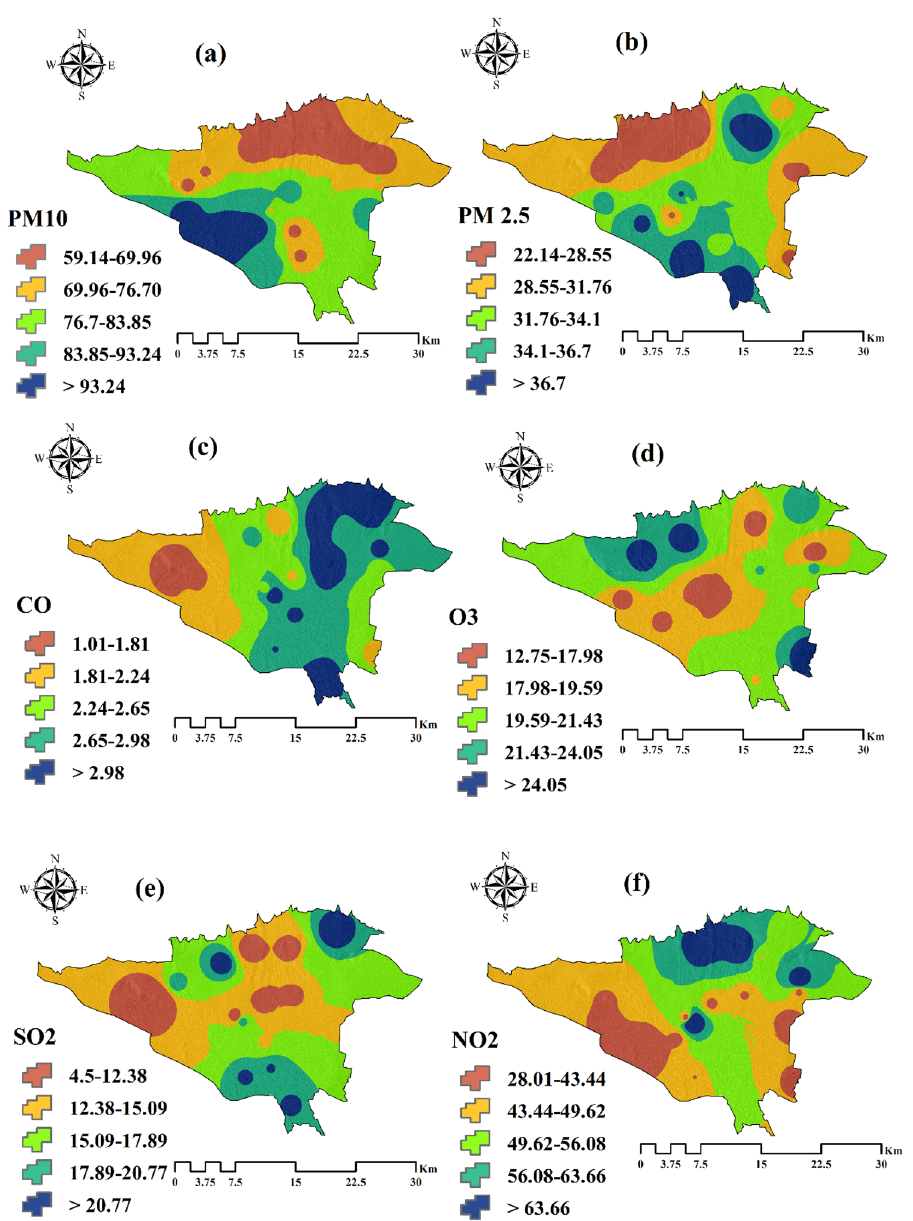
Figure 2. Environmental criteria affecting asthma. ( a ) Particulate matter PM 10, ( b ) PM 2.5, ( c ) CO, ( d ) O 3 , ( e ) SO 2 , ( f ) NO 2 , ( g ) Pressure, ( h ) Wind speed, ( i ) Humidity, ( j ) Temperature, ( k ) Rainfall, ( l ) Distance to street, and ( m ) Distance to park. This map was generated using the tool of ArcGIS 10.3 (ESRI, Redlands, CA, USA, http://